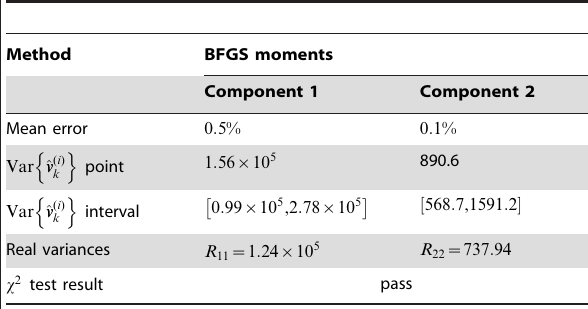
Table 4. x 2 test results for the estimation of 6 parameters in the heat shock model (genetic